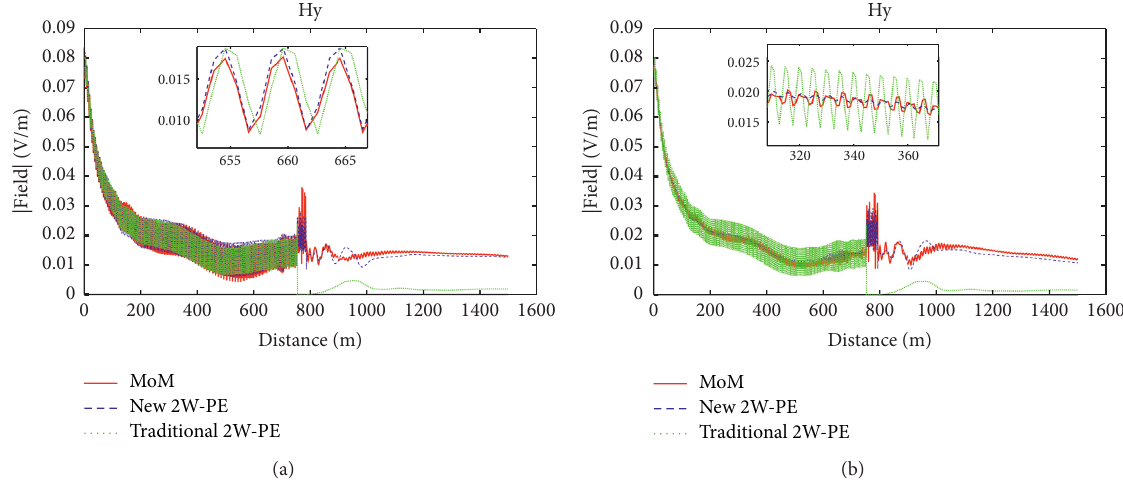
Figure 8: Comparison of total field values in the case of single rectangular medium obstacle of V Pol. (a) D � 33m. (b) D � 40m.